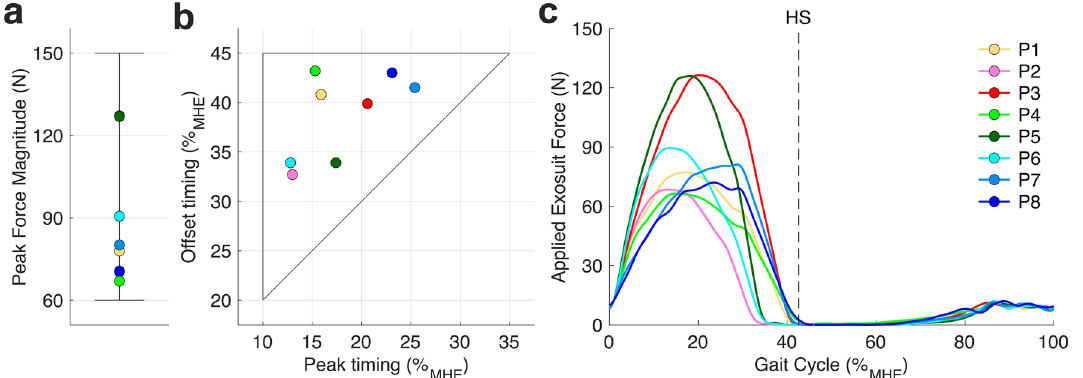
Figure 2. Optimal parameters. Optimal ( a ) peak magnitude ( F peak ) and ( b ) peak timing ( T peak ) and offset timing ( T offset ) in % MHE gait cycle, segmented by a maximum hip extension (MHE), for each participant. The black solid boundary represents the parameter space. Participants 3 and 5 (P3 and P5) needed high assistance magnitude, whereas the rest of the participants needed low to medium assistance magnitude. P2, P5, and P6 had early peak and early offset optimal timings. P1 and P4 had early peak but late offset optimal timings. P3, P7, and P8 had late peak and late offset optimal timings. ( c ) The resultant optimal force profile applied to each participant. Each color represents one participant. The vertical dashed line indicates a heel